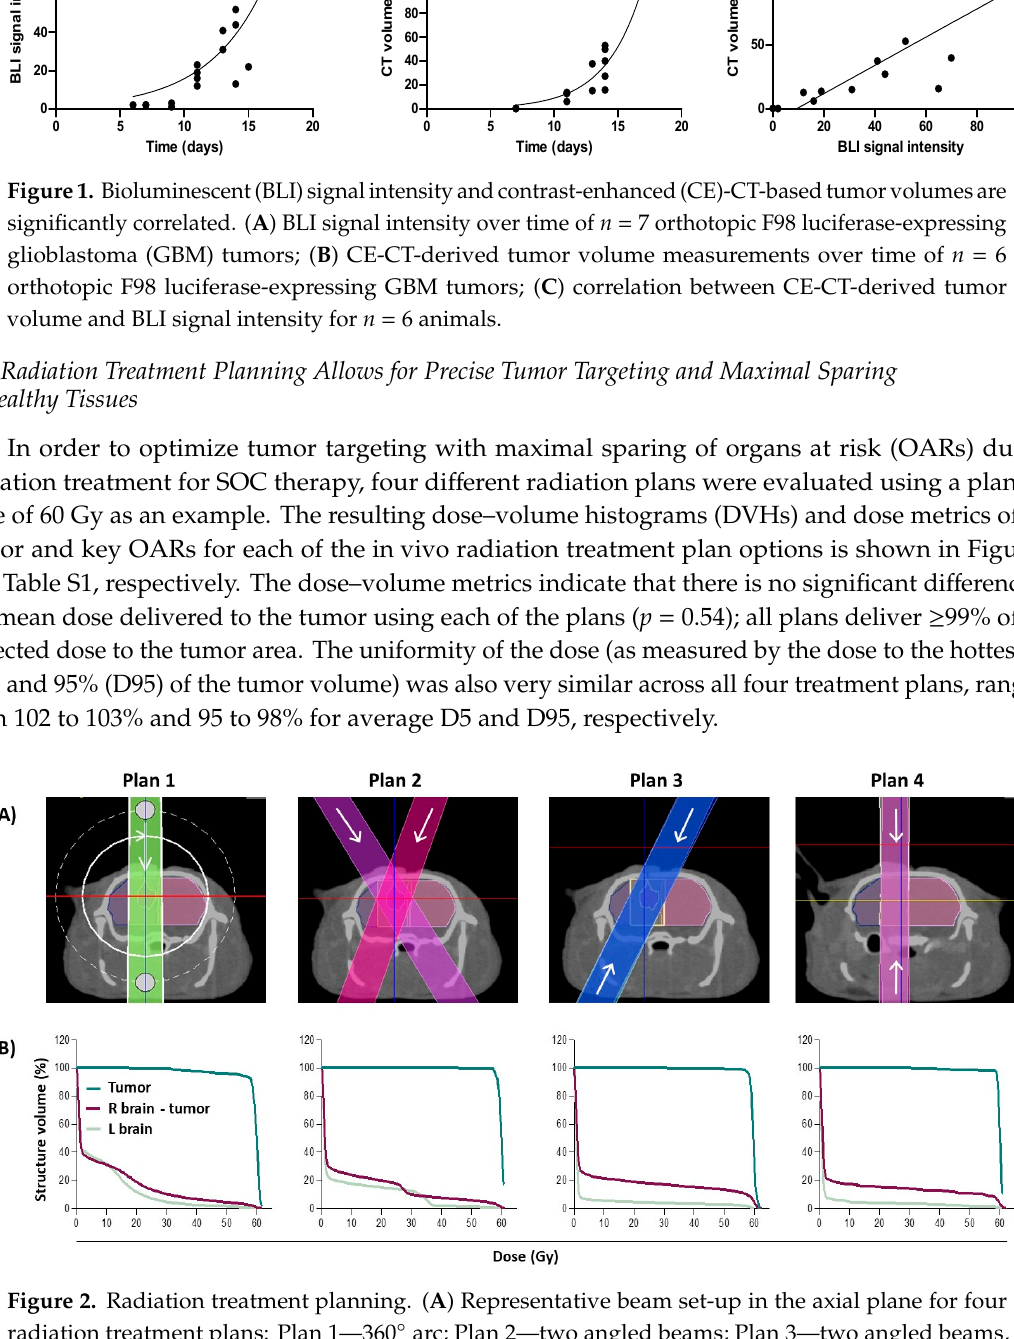
Figure 2. Radiation treatment planning. ( A ) Representative beam set-up in the axial plane for four radiation treatment plans: Plan 1—360 ◦ arc; Plan 2—two angled beams; Plan 3—two angled beams, parallel opposed; Plan 4—anterior / posterior opposed (AP-PA). ( B ) The corresponding dose–volume histograms for each radiation treatment plan. R brain = right brain; L brain = left brain.